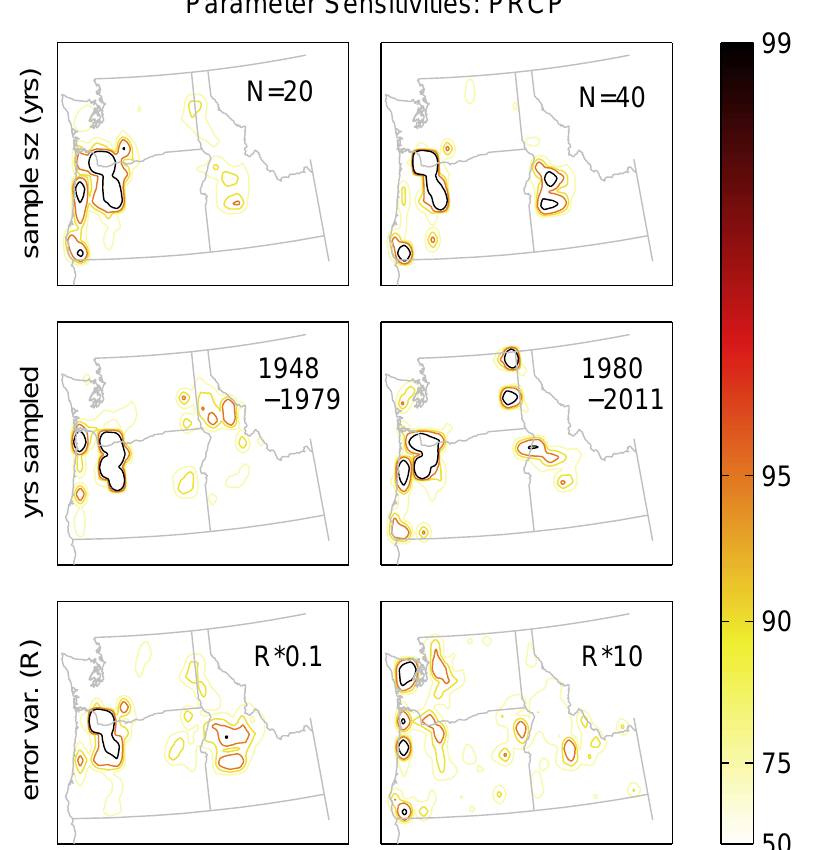
Fig. 5. As in Fig. 4 except applied to annual